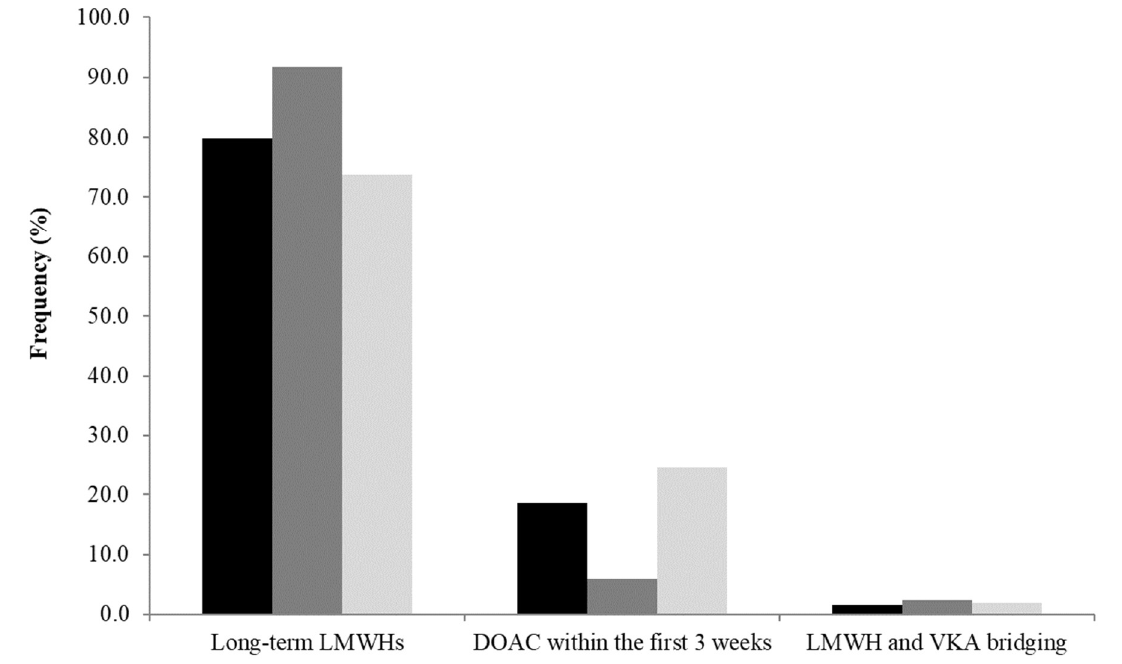
Figure 2. Anticoagulants initiated in a patient with a proximal thromboembolic event and an advanced cancer (according to the site: lung, colorectal, breast). Black: adenocarcinoma of the lung; Dark grey: colorectal cancer; Light grey: breast cancer. DOAC: Direct oral anticoagulant; LMWH: low molecular weight heparin; VKA: vitamin K antagonist.